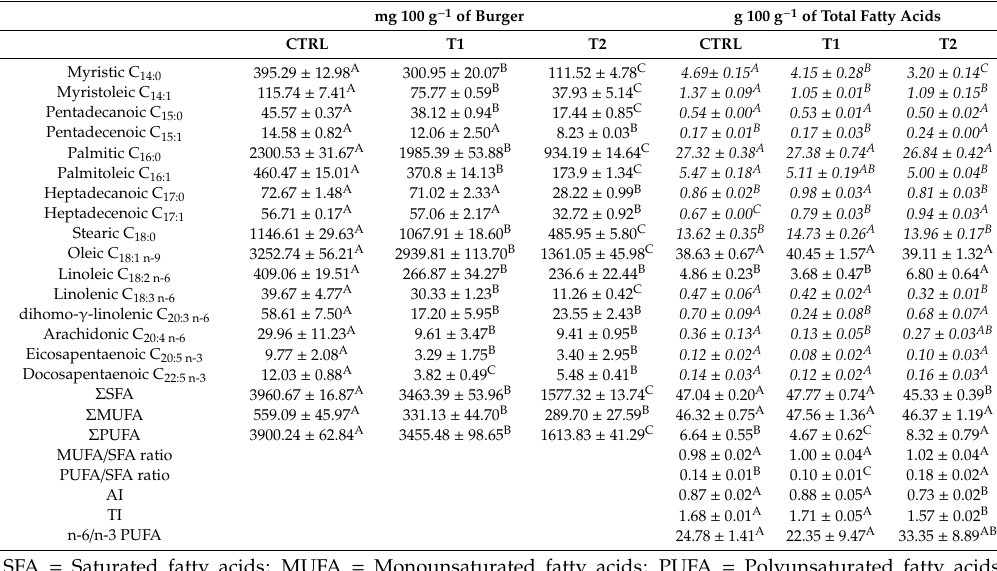
Table 3. Fatty acid composition (g 100 g − 1 of burger and g 100 g − 1 of fatty acids) and the nutritional index of the beef burger without fat substitution (CTRL) and at 50% (T1) and 100% (T2) of fat substitution with an oat-hull-based